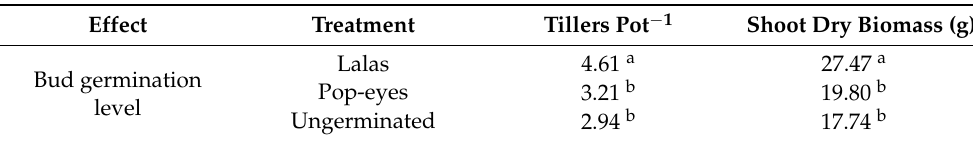
Table 2. Mean tiller production and shoot dry biomass in response to different bud germination levels in first greenhouse experiment a